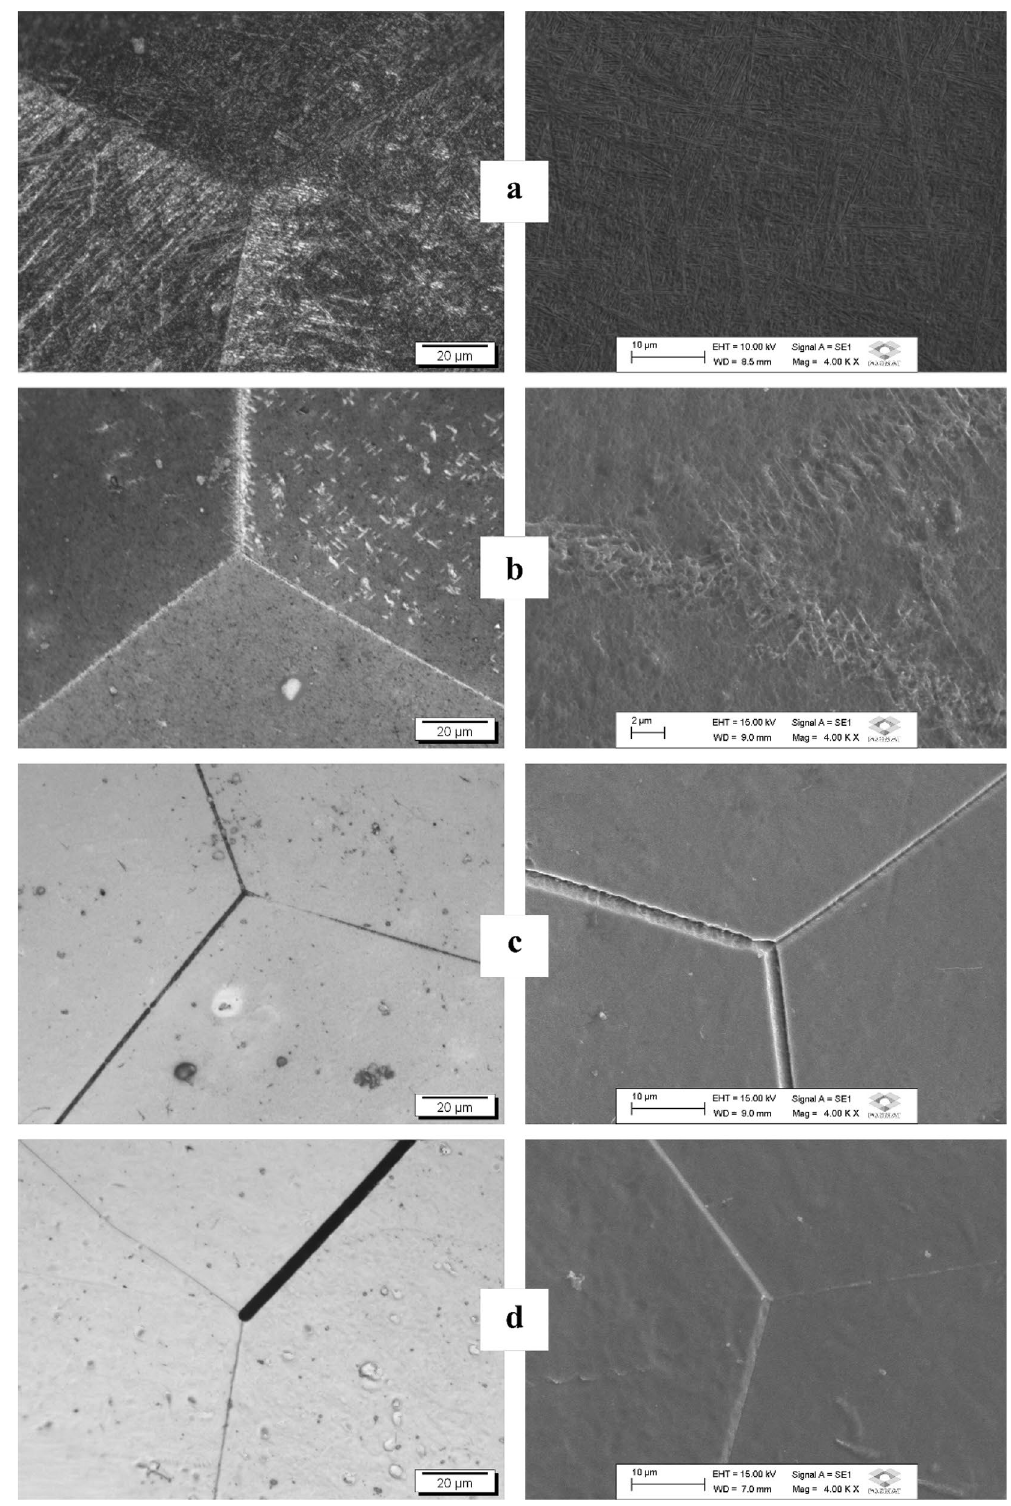
Figure 5. OM, with 1000 × magnification (left), and SEM, with 4000 × magnification (right) of as-cast Ti-5Mo (a), Ti-5Mo-10Nb (b), Ti-5Mo-20Nb (c) alloys and Ti-5Mo-30Nb (d)